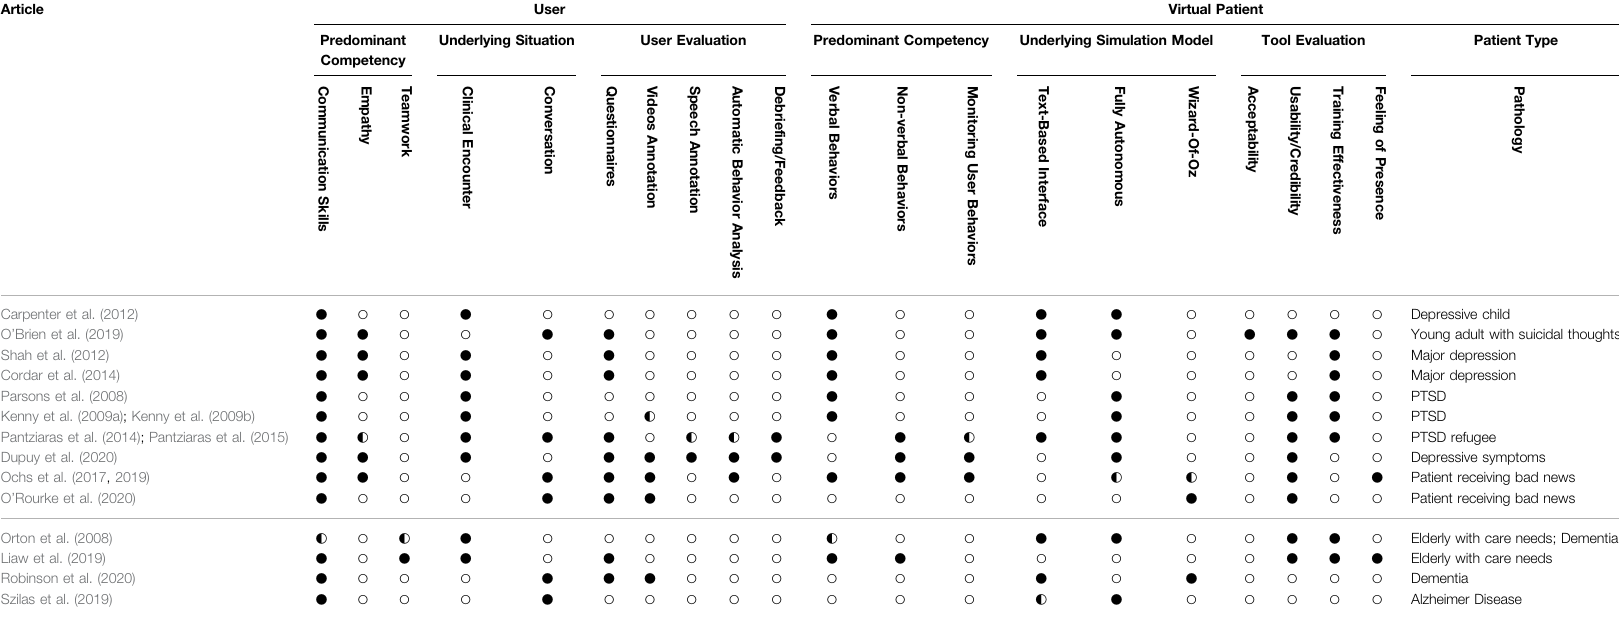
Table1| Overviewofannotatedattributesinourselectedlistofarticlespresentedon Section2 .Theannotationprocedure capturestheuserandtheVPcharacteristics insimulationtoolsforclinician-patient communication in the fi eld of psychiatry and geriatrics. Article